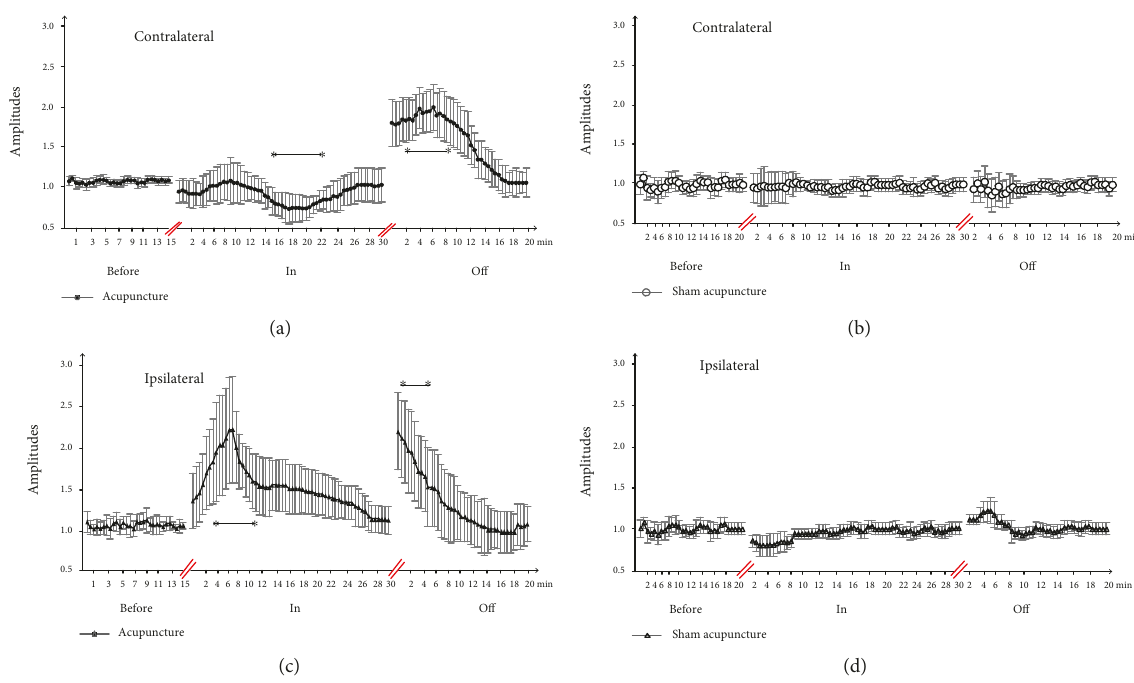
Figure 3: (a, c) Amplitude modulation of MEPs in the left FDI muscle following acupuncture during the di ff erent phases of the experimental protocol and (b, d) amplitude modulation of MEPs in the left FDI muscle following sham acupuncture groups during the di ff erent phases of the experimental protocol. The “ Before ” panel indicates the baseline before acupuncture application, whereas the “ In ” panel denotes the average values across participants for the experiments in which the needle was in situ for 30 minutes. The “ O ff ” panel refers to the data recorded after the needle removal within 20 minutes. Graphical illustration of the mean MEP amplitudes over the whole acupuncture is presented. The asterisks indicate the statistical signi fi cance compared with the baseline. The levels of signi fi cance are as indicated in the text.